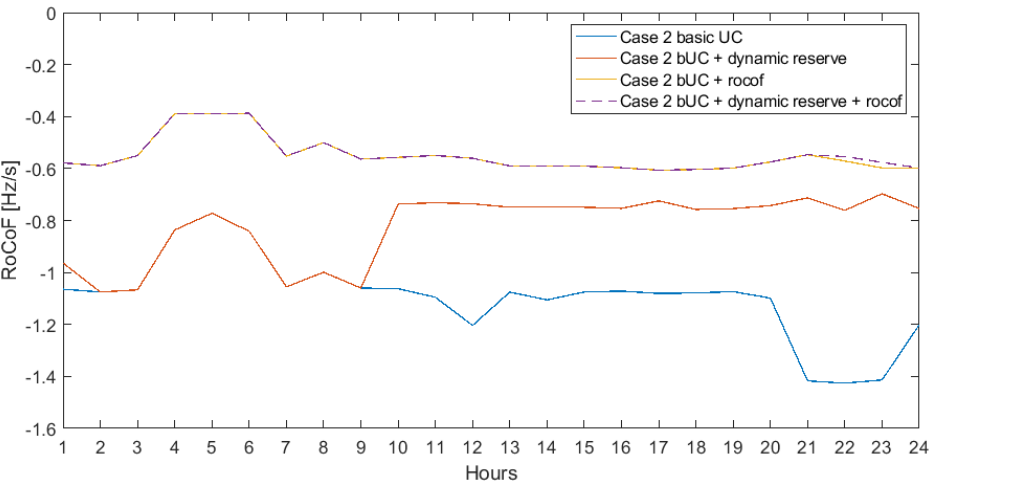
Figure 7. 24-h Case 2 RoCoF under various constraints.